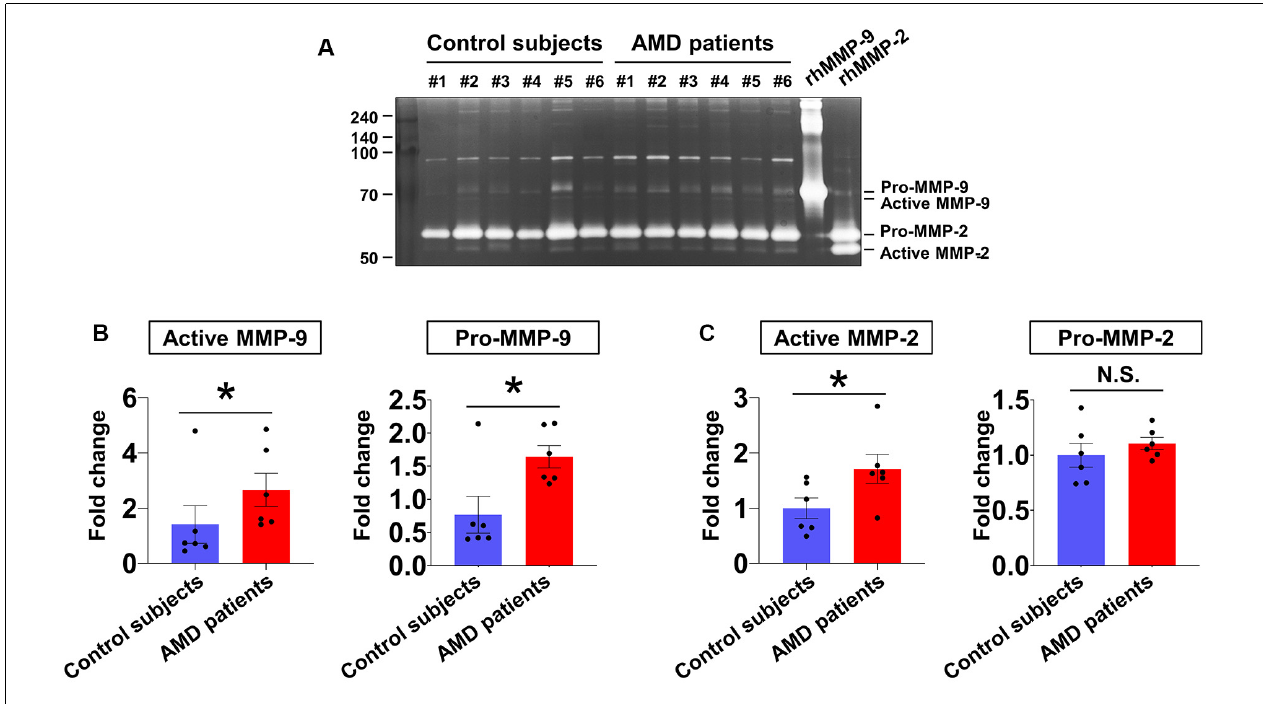
FIGURE 1 | Aqueous humor matrix metalloproteinase (MMP) enzymatic activities in neovascular age-related macular degeneration (AMD) and senile cataract control subjects. (A) Gelatin zymography to detect MMP activity (pro-MMP-9, 95 kDa; active MMP-9, 82 kDa; pro-MMP-2, 62 kDa; active MMP-2, 56 kDa). (B) Relative abundances of pro-MMP-9 and active MMP-9 were quantified by densitometry. Active MMP-9 was elevated in aqueous humor samples from all six neovascular AMD patients compared with age-matched control subjects. * P < 0.05. (C) While active MMP-2 levels were increased in neovascular AMD group relative to control, pro-MMP-2 levels were unchanged. N.S.: